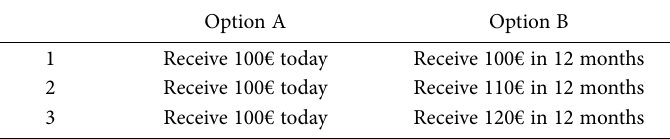
Figure 2. Example of a choice list for experiment 3 (time